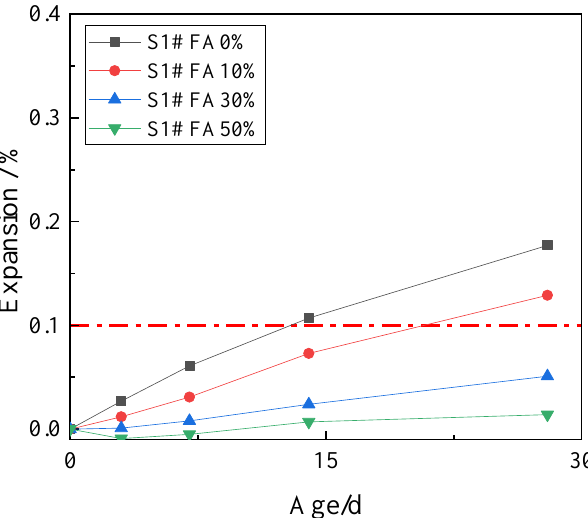
Figure 4. The expansion of the concrete microbars with fly ash.